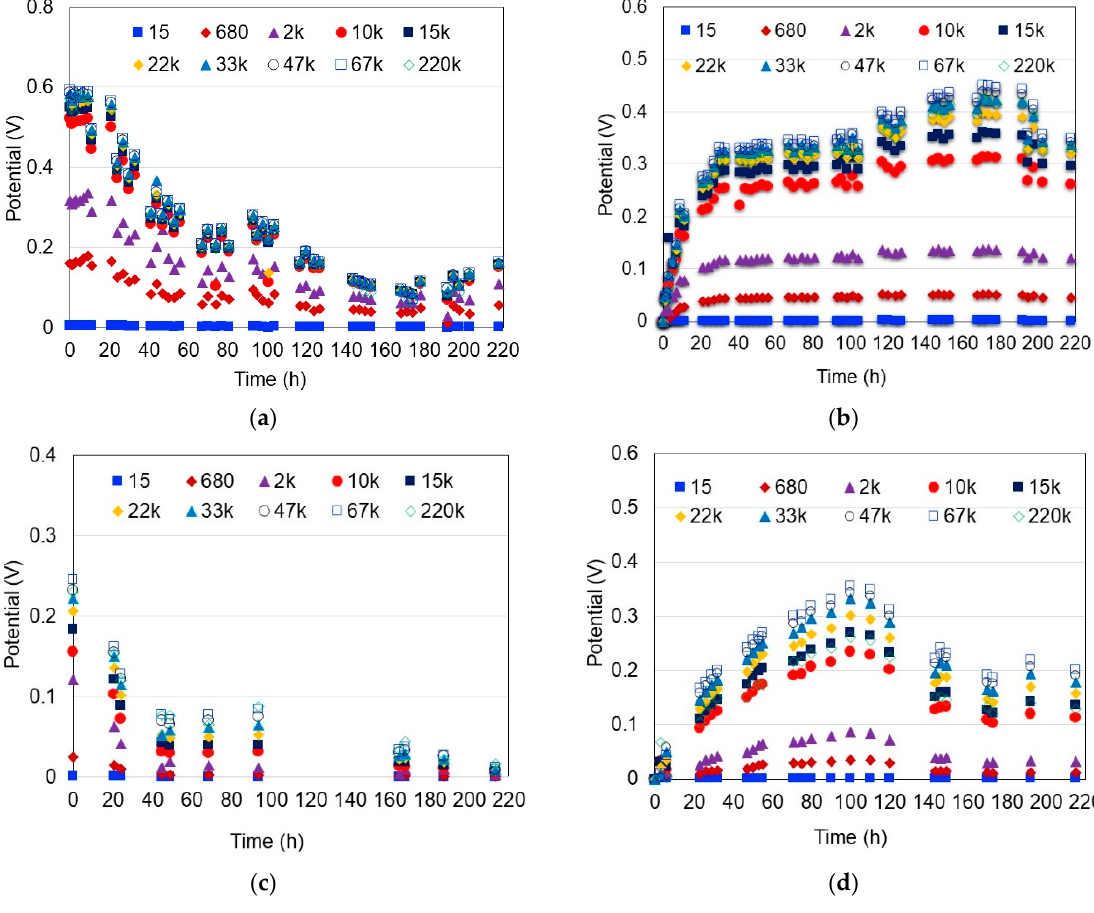
Figure 4. Effect of the external resistance ( Ω ) on the MFC potential. ( a ) Water and hydrophilically- treated graphene (DW-HTG); ( b ) HCl and hydrophilically-treated graphene (HCl-HTG); ( c ) Water and graphite (DW-G); ( d ) HCl and graphite